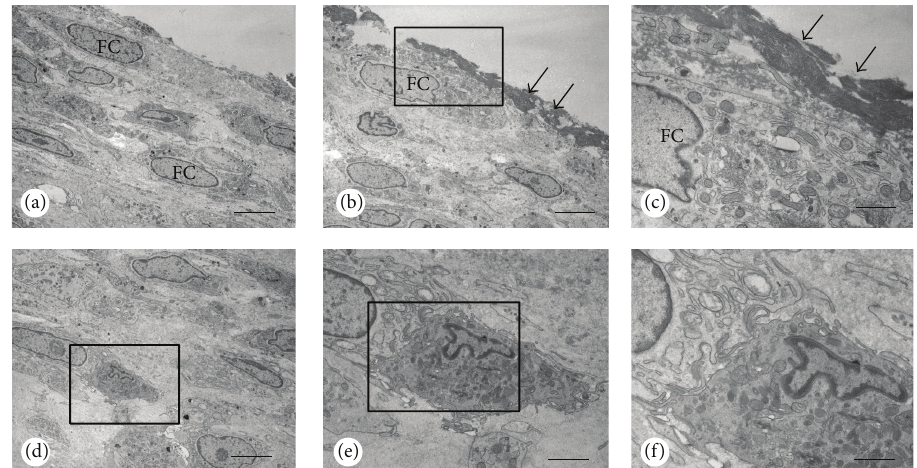
Figure 5: Electron microscopy of articular cartilage surface with moderate joint destruction. The surface of the articular cartilage was composed of a thick layer of fibroblastic cells (FC, a), which were sometimes covered with electron dense materials (arrows, b). At a higher magnification, electron dense materials overlaid the fibroblastic cells with abundant Golgi apparatus and rough endoplasmic reticulum (c). A macrophage can be seen in the inner portion of the fibroblastic cell layer (d). The macrophage contains many lysosomes and vesicles making contact with fibroblastic cells (e, f). Panel (f) is a magnified image of (e). Bars: (a), (b), (d): 10 𝜇 m, (c), (f): 5 𝜇 m, and (e): 7 𝜇